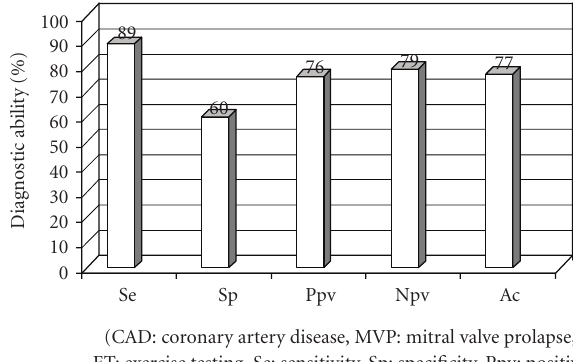
Figure 2: Diagnostic ability of a normal electrocardiogram during hyperventilation in detecting CAD in patients with MVP and positive